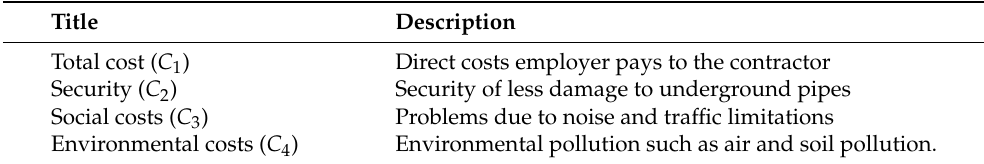
Table 10. Criteria and their description for piping